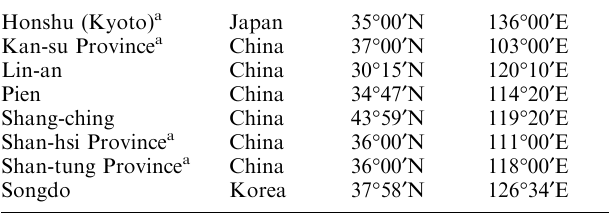
Table 1. Geographic coordinates of the appropriate oriental capitals (or regions) Honshu (Kyoto)